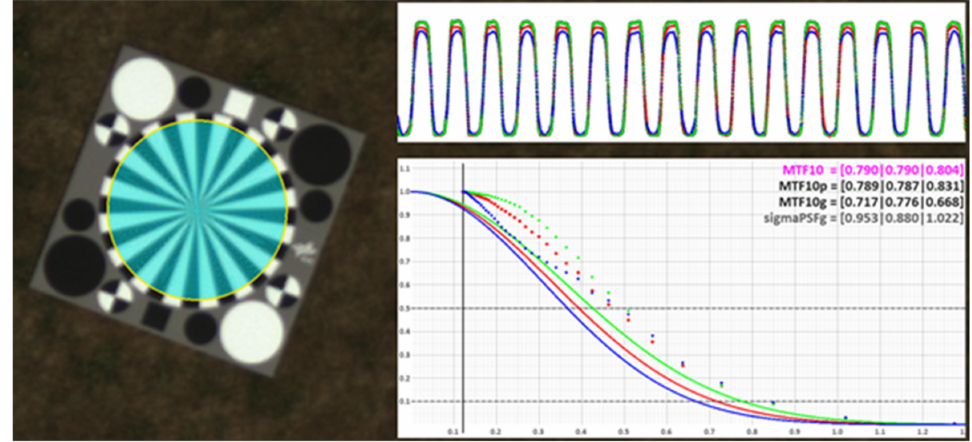
Figure 1. Designated test pattern of Siemens-star ( left ), radial modulation analysis ( top-right ), resulting modulation transfer function (MTF) (unit line/pixel) and point spread function (PSF) ( bottom-right